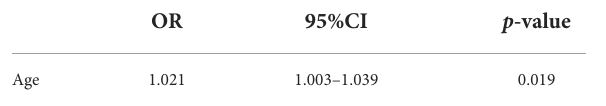
TABLE 7 Changes of EQ-5D in patients with successful CTO-PCI. TABLE 8 Univariable logistic regression for 1-year QOL improvement in patients with low eGFR ( < 90 mL/min/1.73 m 2 ) after successful